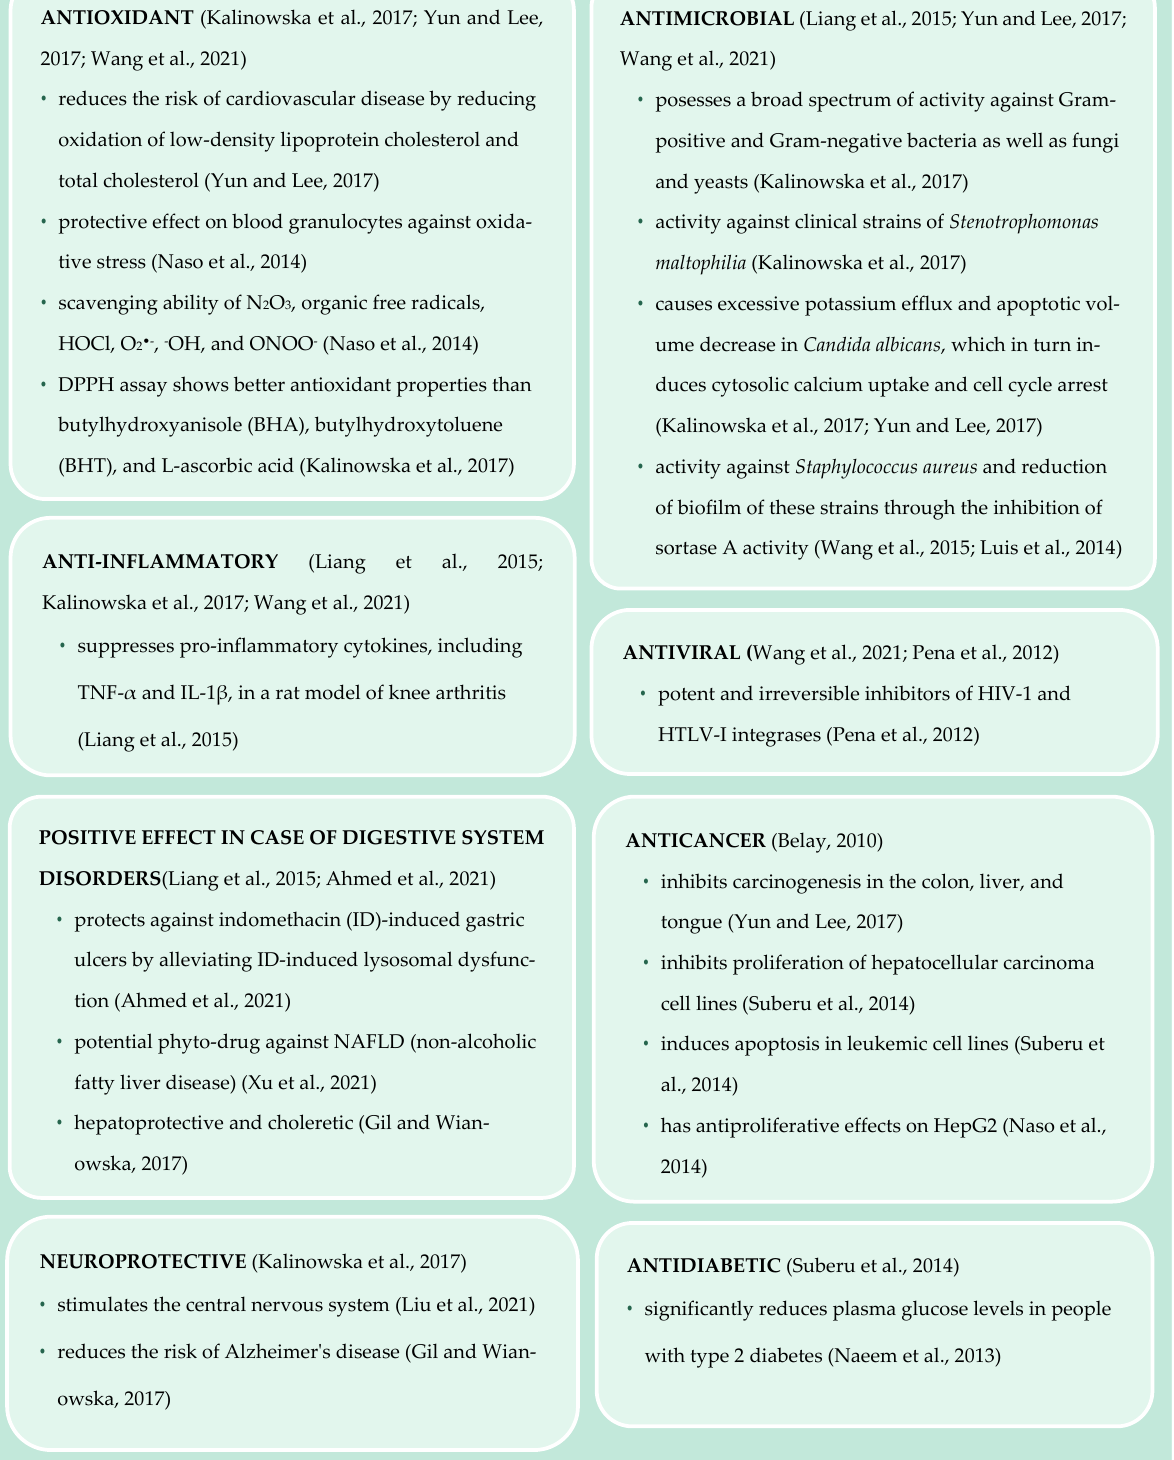
Figure 1. Biological properties of chlorogenic acids (CQAs) [2,4,5,11,12–19,25–27].